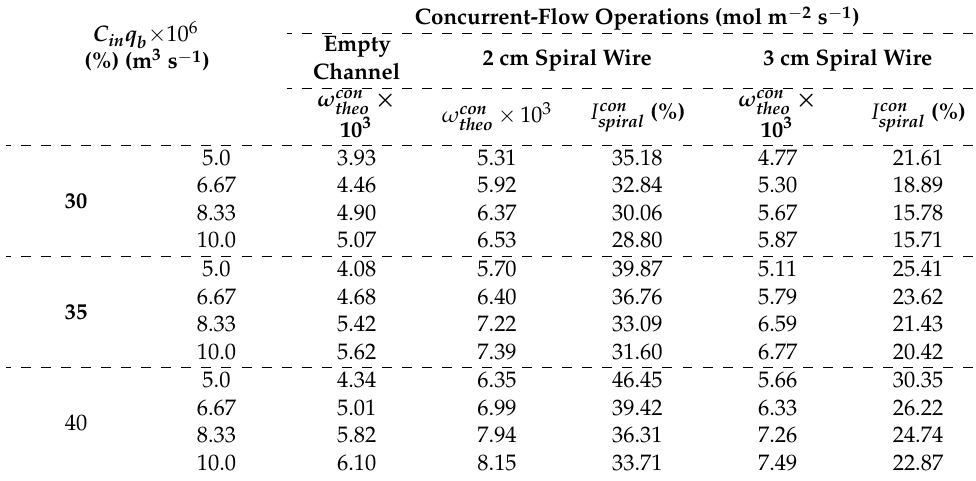
Figure 11. Effects of MEA flow rate and spiral-wire pitch on CO 2 absorption flux. ( a ) Concurrent-flow operations; ( b ) Countercurrent-flow operations.